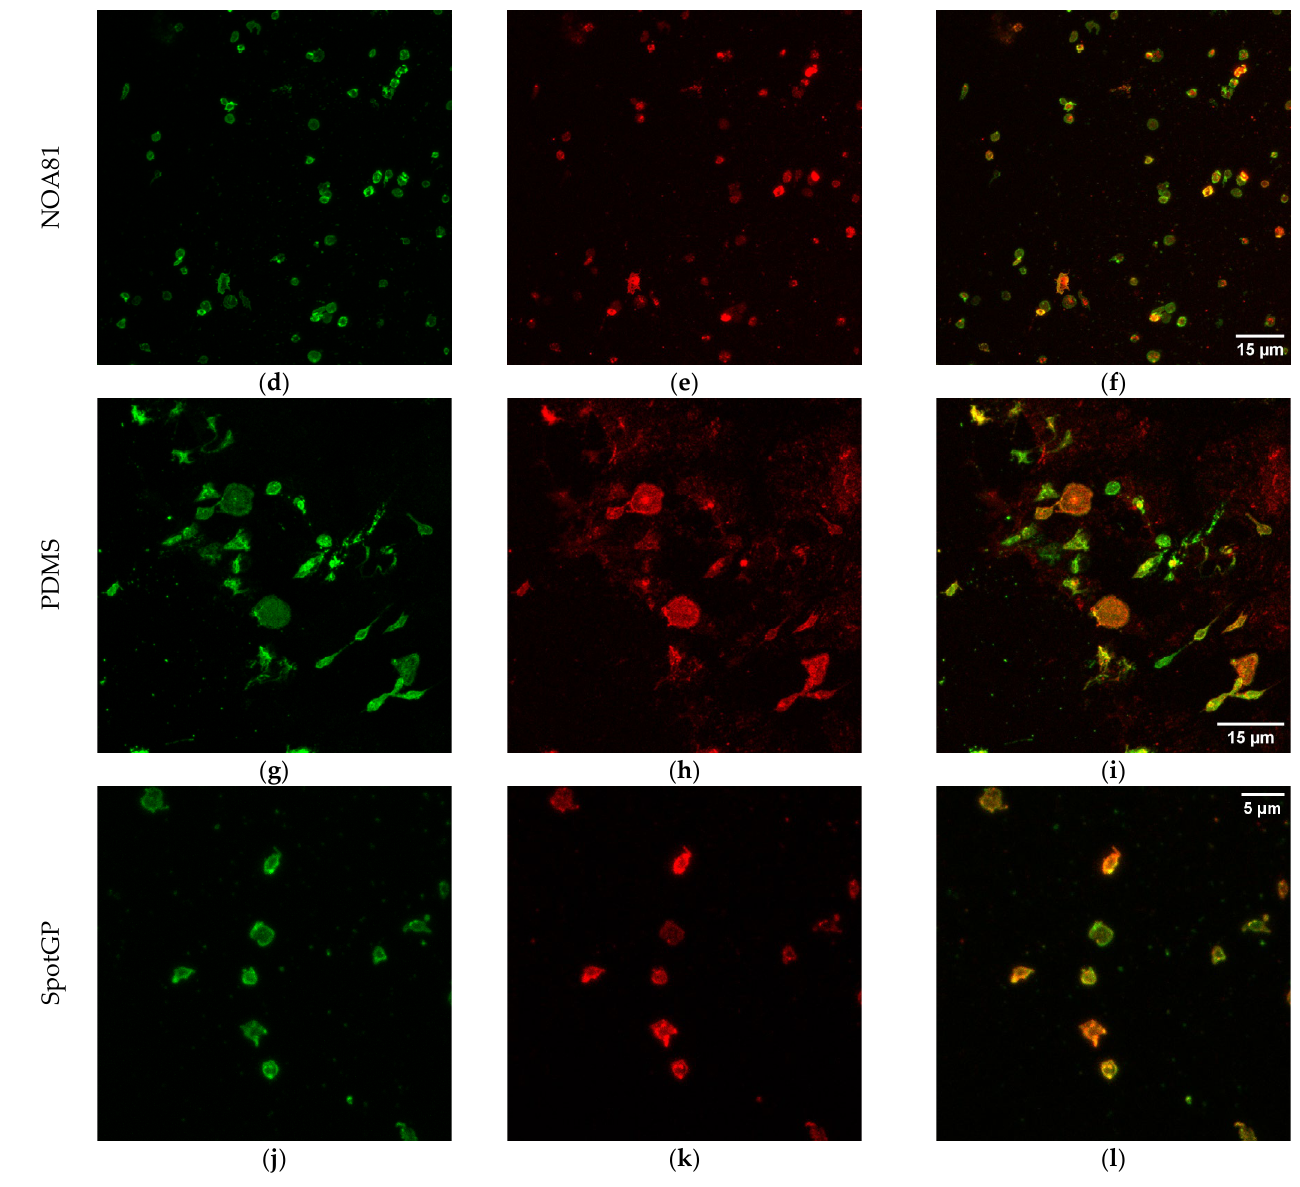
Figure 5. Confocal images of platelets adherent to polymeric materials. In the first column, the signal of CD41 is reported (panels ( a , d , g , j )), while, in the second, the signal of CD62P is shown (panels ( b , e , h , k )). The last column refers to merged signal (co-localization, ( c , f , i , l )). Scale bars: 5 µ m for COC and SpotGP, 15 µ m for NOA81 and PDMS.